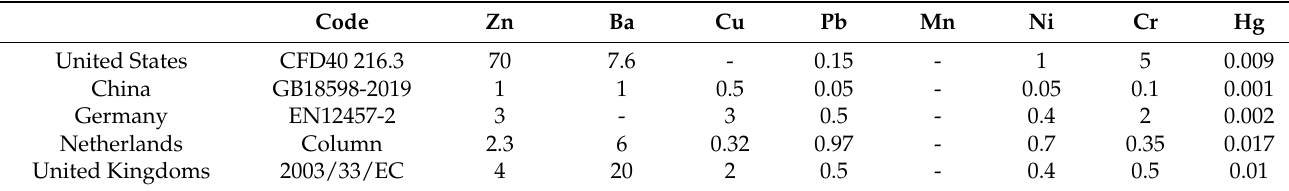
Table 4. Leaching limits of selected HMs for the acceptance of solid waste at landfills in different countries (mg/L). (updated from